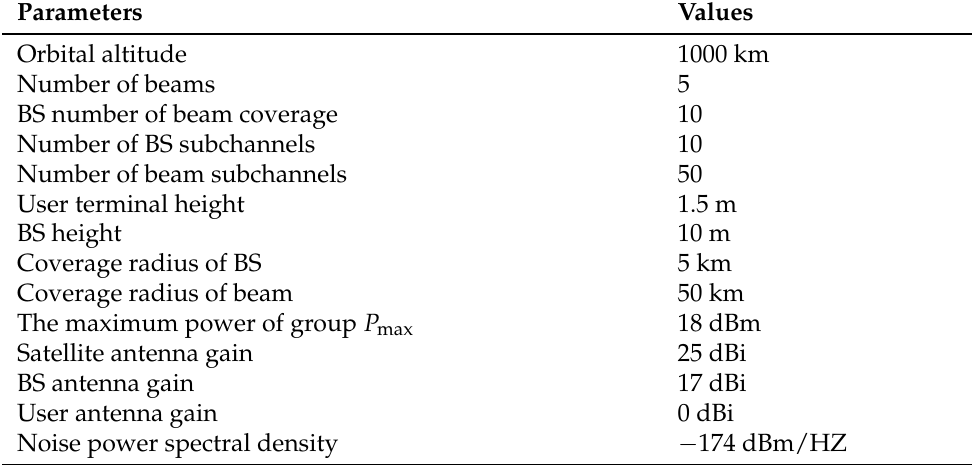
Table 2. Simulation